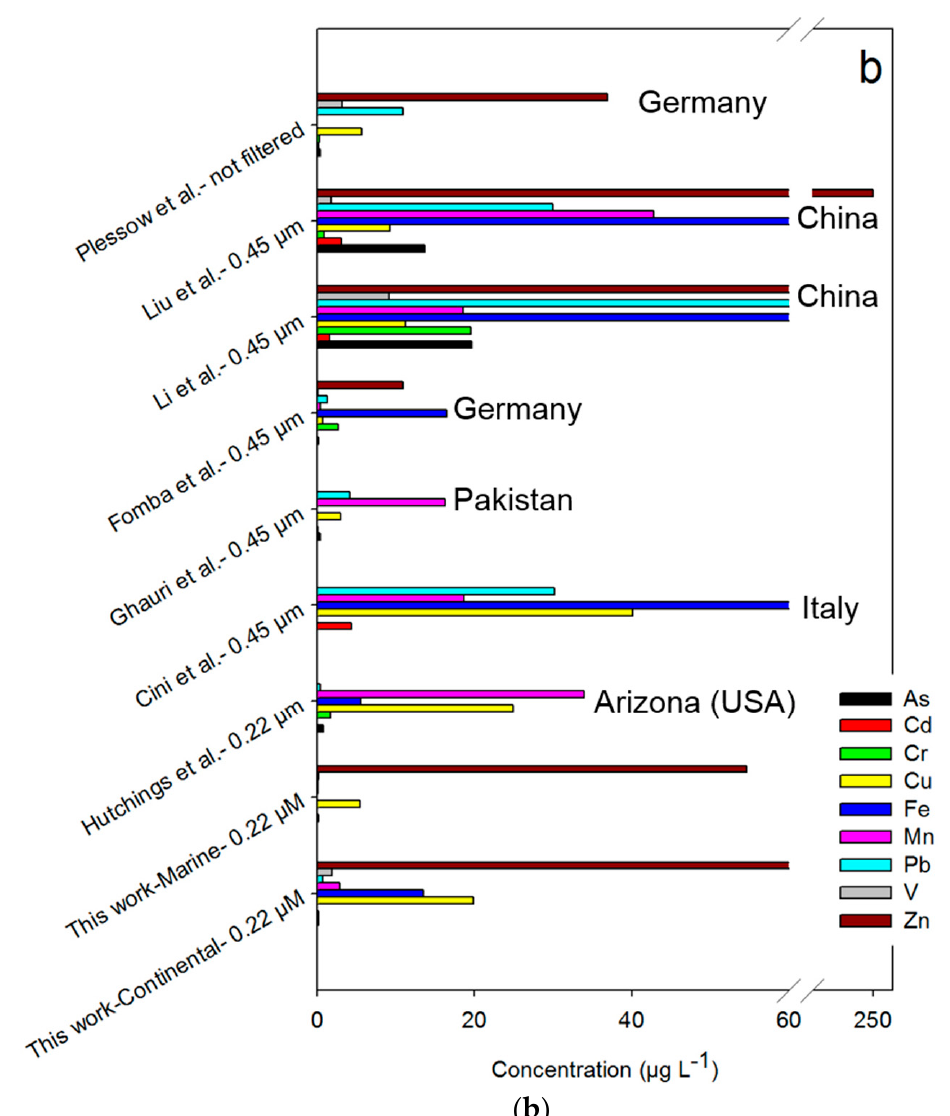
Figure 2. ( a ) Box-plot showing concentration of trace metals in this work. The boundary of the box closest to zero indicates the 25th percentile, a line within the box marks the median, and the boundary of the box farthest from zero indicates the 75th percentile. Whiskers above and under the box indicate the 90th and 10th percentiles. Mg and Zn are reported in mg L − 1 in red (right axis); ( b ) Comparison between data reported in this work and from other sites. (Hutchings et al. [37]: filtered 0.22 µm; Cini et al. [13]: filtered 0.4 µm; Ghauri et al. [16]: filtered 0.45 µm; Fomba et al. [13]: filtered 0.45 µm; Li et al. [15]: filtered 0.45 µm; Liu et al. [38]: filtered 0.45 µm; Plessow et al. [5]: not filtered.); (Site characteristics are reported in Table S2.).